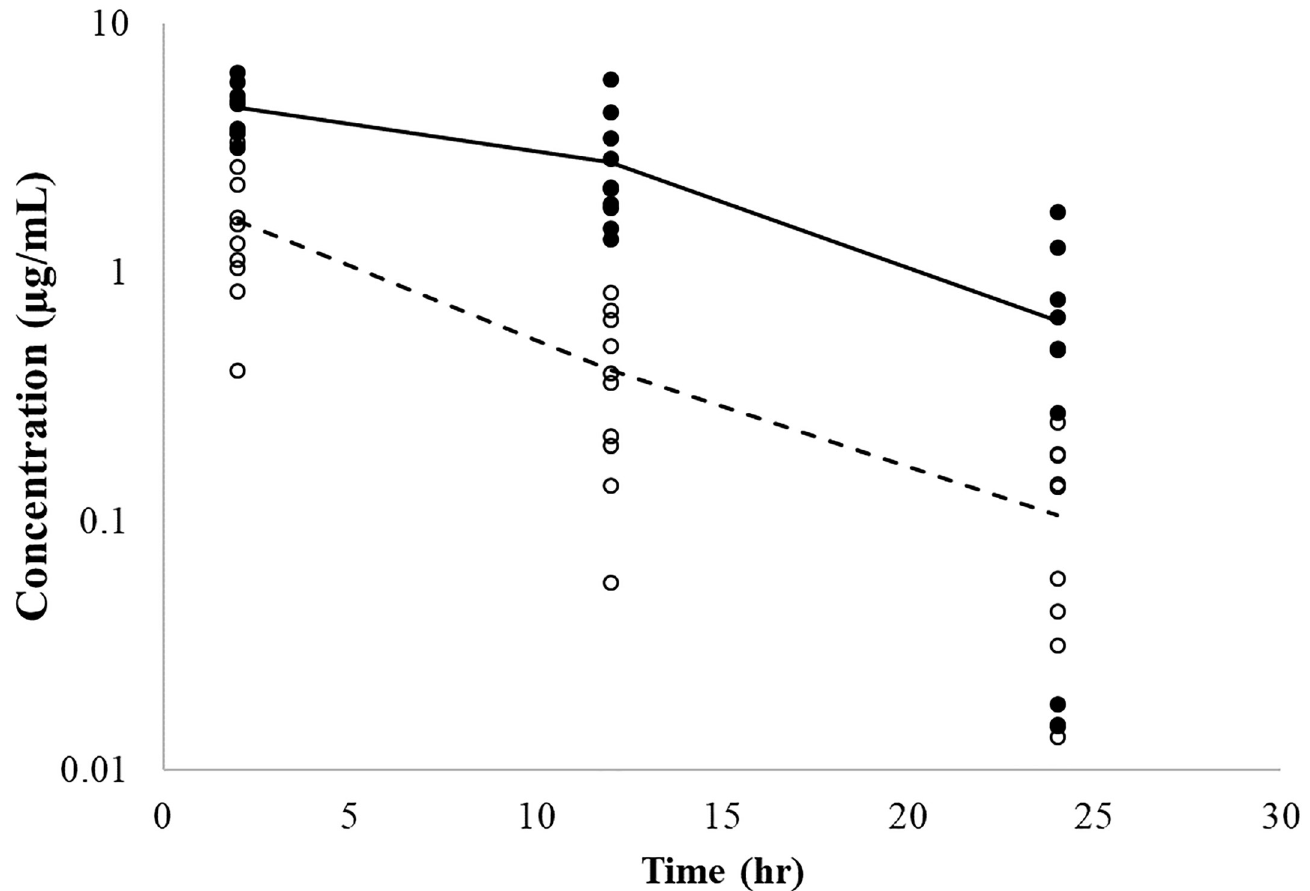
Fig 4. Individual PELF concentrations of danofloxacin. Lines represent average concentration over time for 3-week old calves (solid line) and 6-month old calves (dashed line).